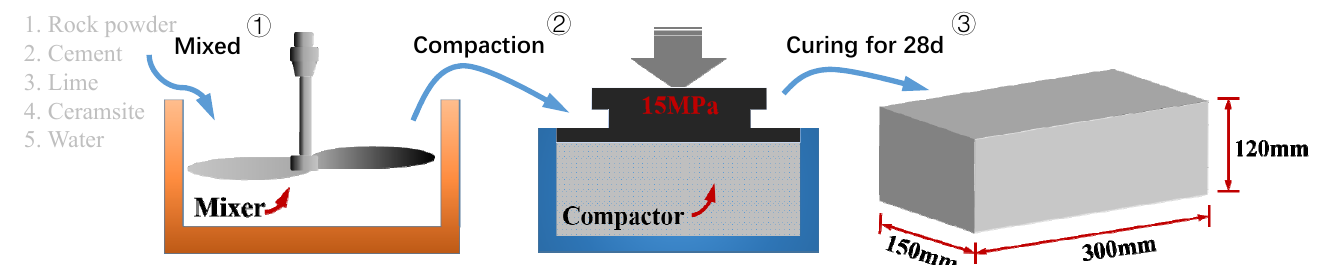
Figure 3. Diagram of the production process of NCRPB.